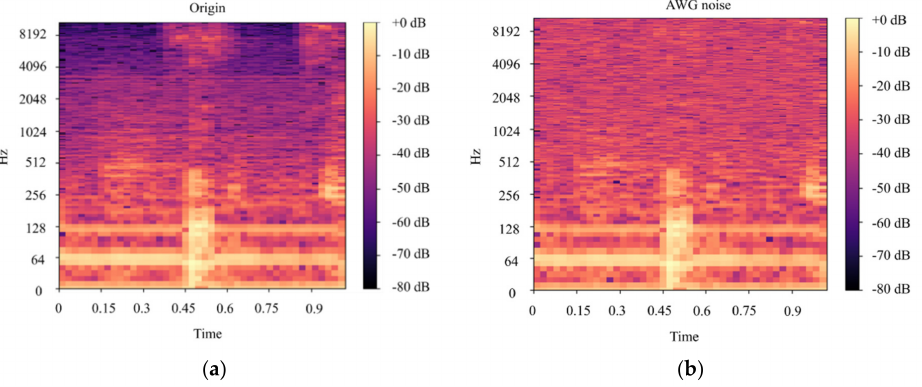
Figure 7. Spectrograms before and after adding noise operation. ( a ) Original spectrogram, ( b ) spectrogram after adding AWG